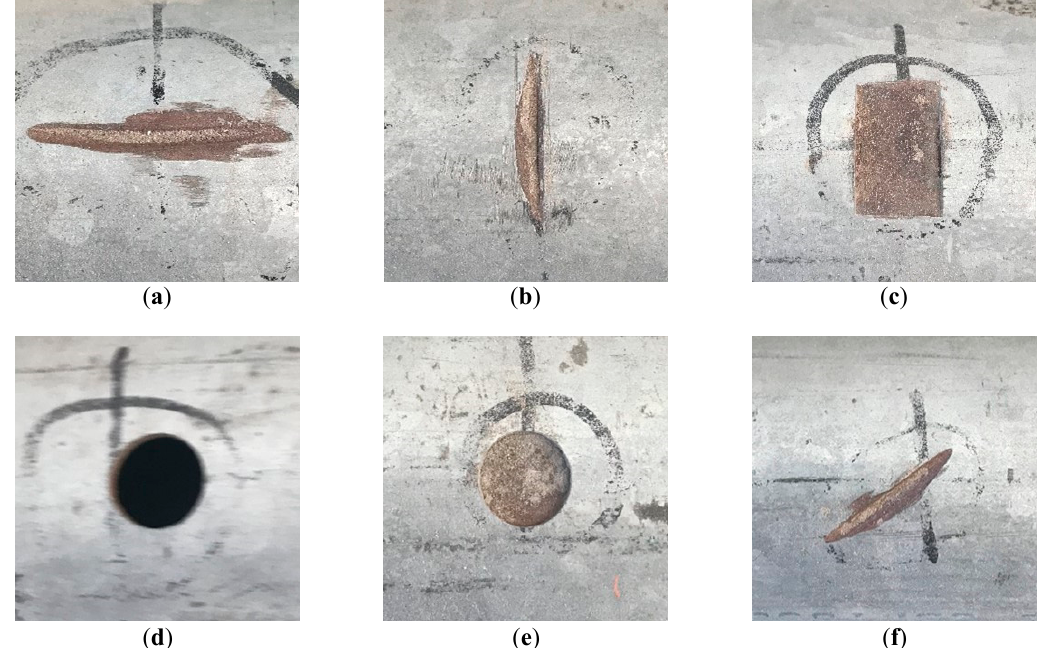
Figure 9. Images of defects in the ferromagnetic pipeline. ( a ) The size of axial crack is 30 mm × 1 mm ×